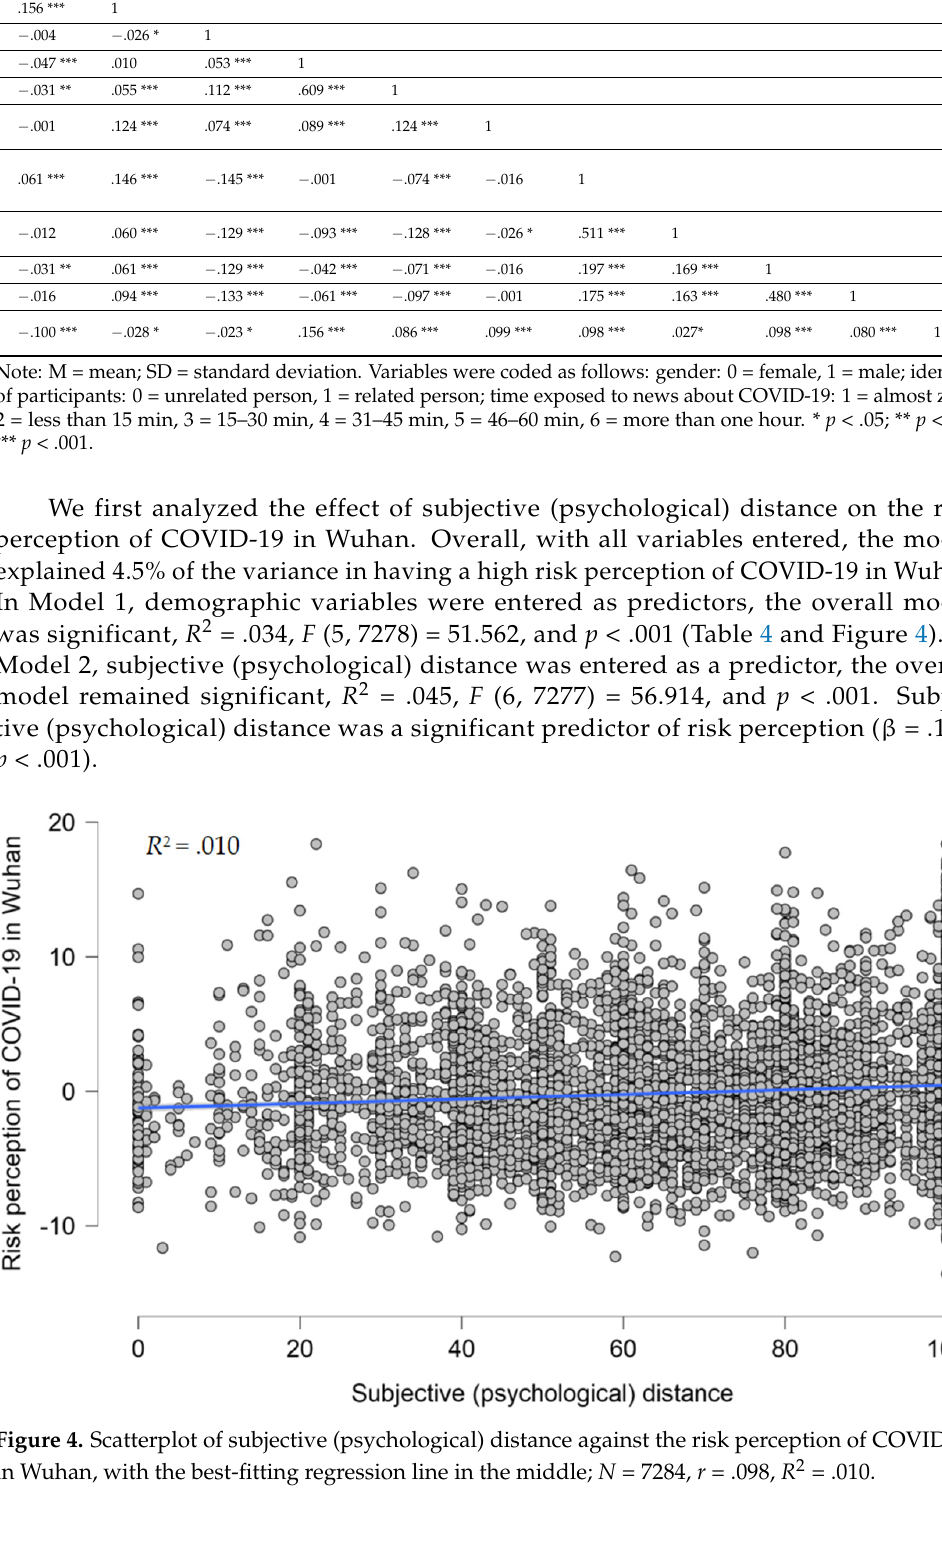
Figure 4. Scatterplot of subjective (psychological) distance against the risk perception of COVID-19 in Wuhan, with the best-fitting regression line in the middle; N = 7284, r = .098 , R 2 = .010.